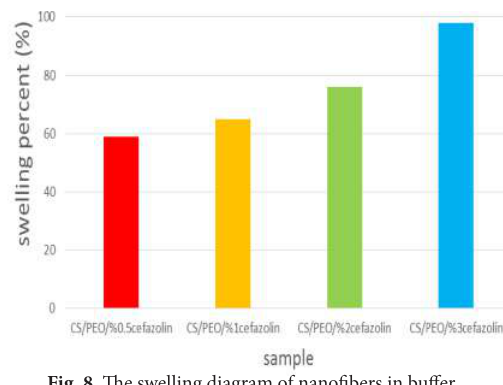
Fig. 8. The swelling diagram of nanofibers in buffer with pH 5.5 and 37oC temperature